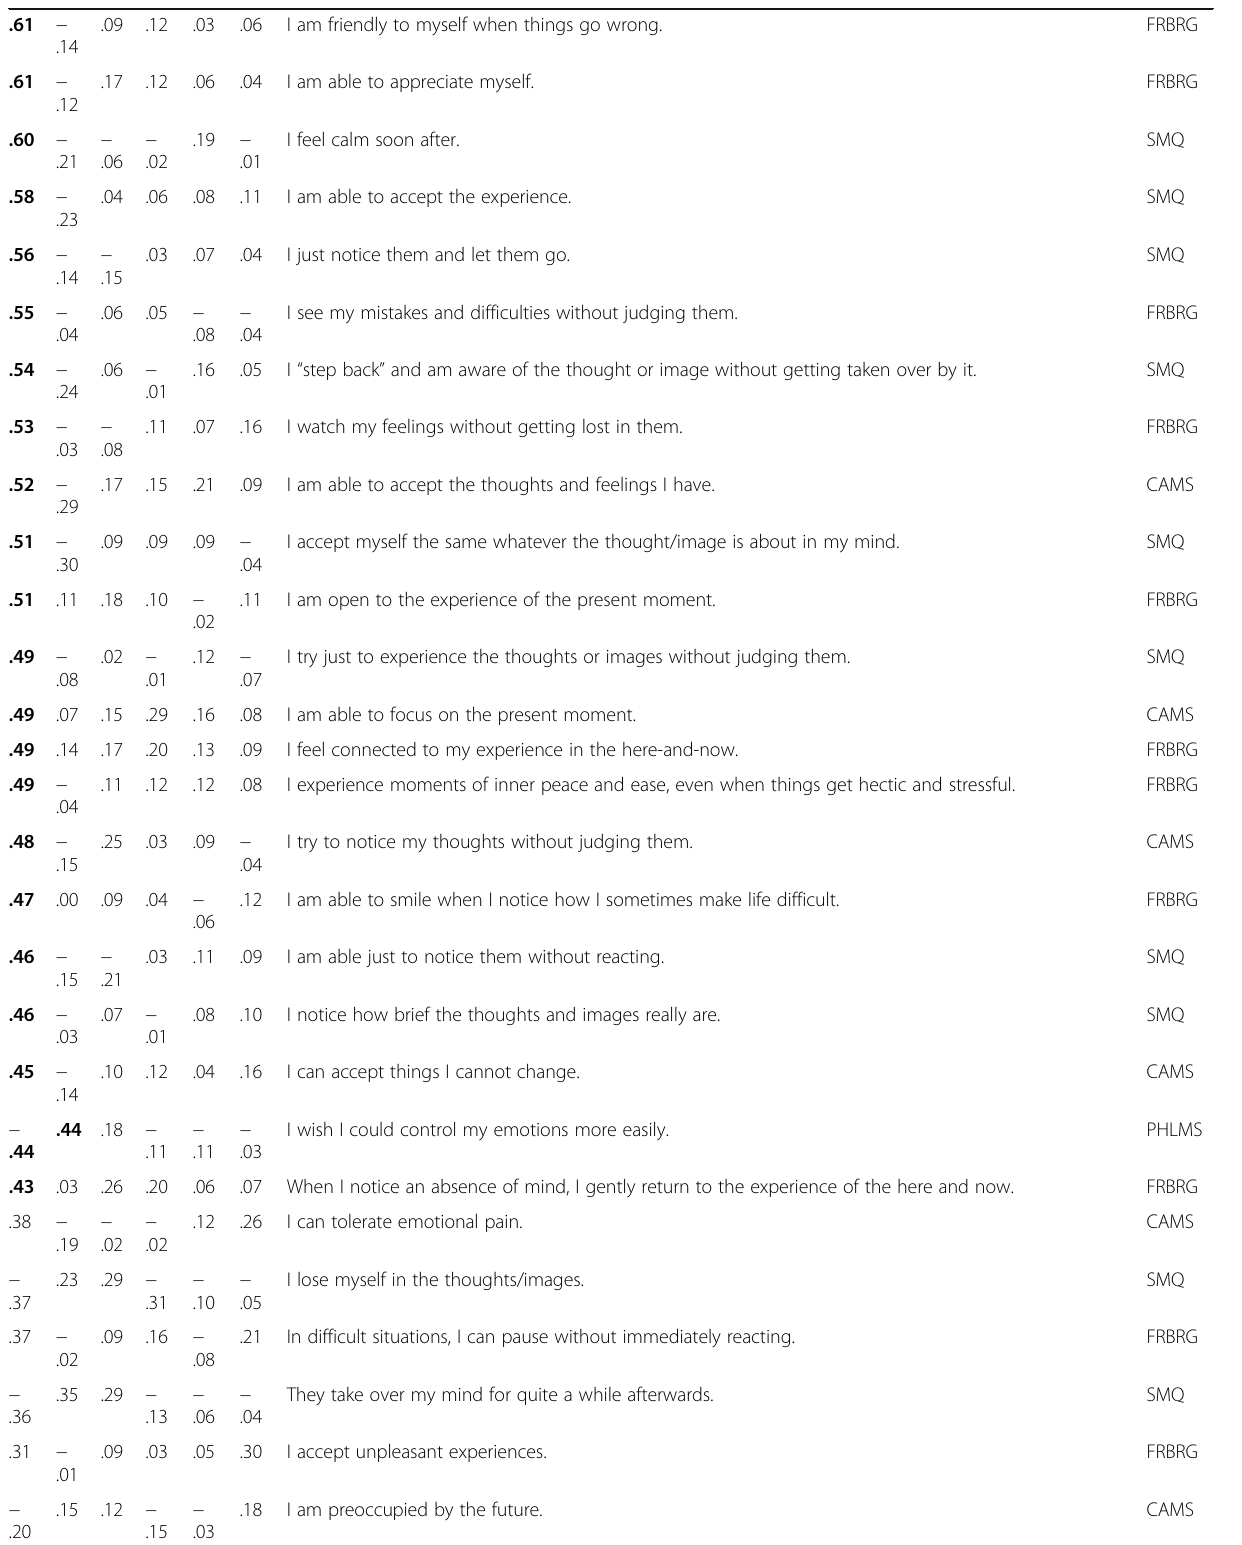
Table 4 Component loadings of the mindfulness items on the final six